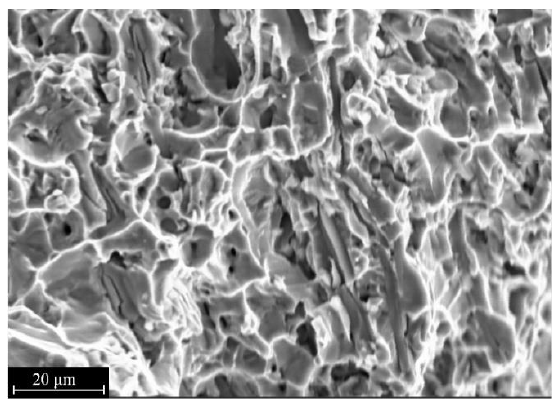
( b ) Figure 20. TiB particles in the deformed titanium matrix of the Ti-TiB alloy of a (Ti-TiB)–T110 welded joint: ( a ) boride plate retained integrity while deforming (TiB n : n = 1.47 (1); 1.01 (2); 1.16 (3)); ( b ) defragmented boride plate ( n = 1.06). During the tensile testing of dissimilar welded joints of Тi-TiB and Т110 alloys, produced under low electron beam velocities, a certain level of plasticity was observed: at the minimum electron beam movement velocity of 7 mm·s −1 it was 1.2%, and at the electron beam movement velocity of 13 mm·s −1 it was 4.9%, but plasticity increase resulted in strength decrease (see the Figure 19).